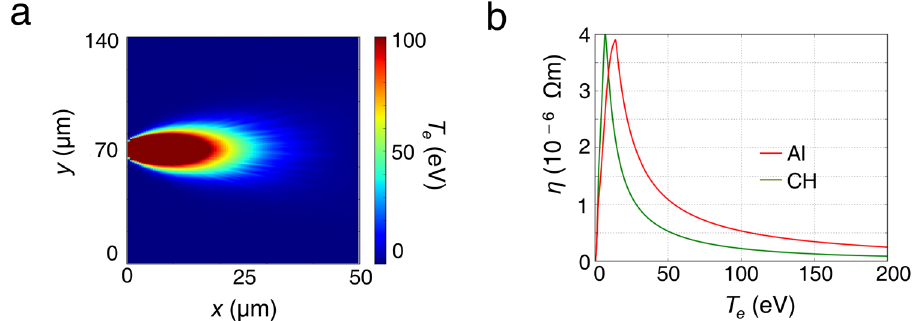
Figure 4. ( a ) Temperature ( T e ) contours in the x − y plane along the longitudinal direction in the CH target, 0.7 ps after the interaction. ( b ) Resistivities of CH (green) and Al (red) as a function of bulk temperature. The saturated region indicates temperatures greater than 100 eV. The simulations indicate that CH is more resistive than Al at lower temperatures, although this is not true above 20 eV. Most of the CH target reaches temperatures above 20 eV and consequently, a high degree of filamentation is not expected in the CH target at these early time-scales, consistent with our experimental